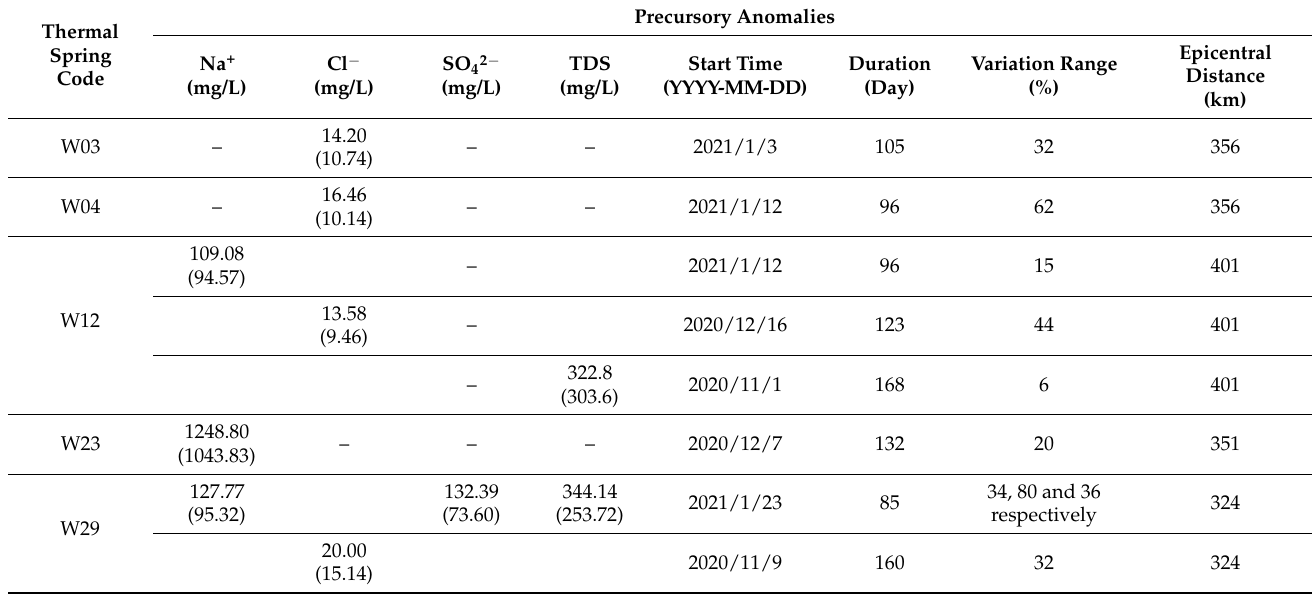
The numbers in parentheses represent the average value of the ion concentrations in each thermal